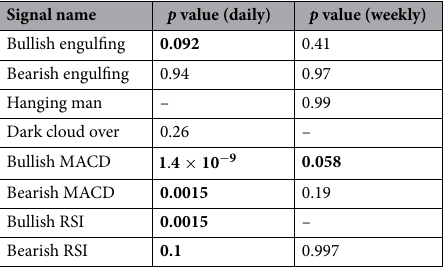
Table 4. Global statistical significant of each technical indicator for stock market data. We calculate the p values for both weekly and daily partitions of the data. Statistically significant p values (those < 0.1 ) are shown in